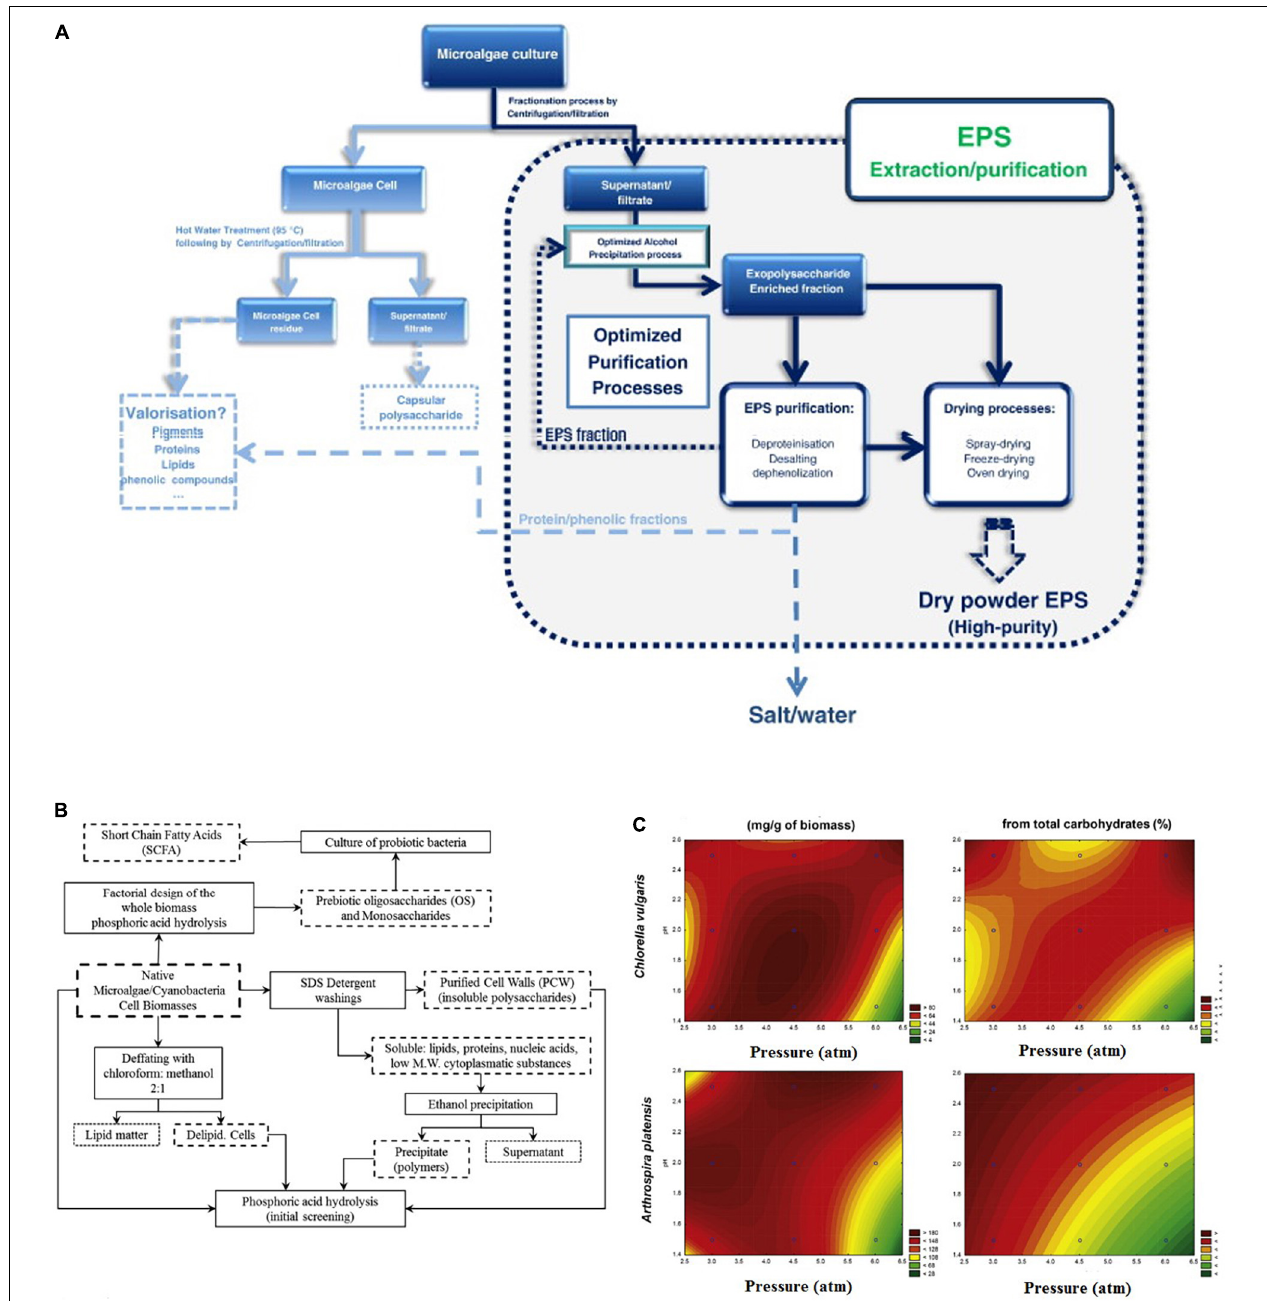
FIGURE 6 | Extraction and purification of bioactive prebiotics. (A) Traditional strategy for the extraction and purification of exopolysaccharides from microalgae. (B) Thermophosphoric hydrolysis preparation strategy for the extraction and purification of microalgae oligosaccharides. (C) Contour plots for oligosaccharide production and purity via thermophosphoric hydrolysis of two microalgae species (53, 65) (Copyright permissions: 5179210453569,